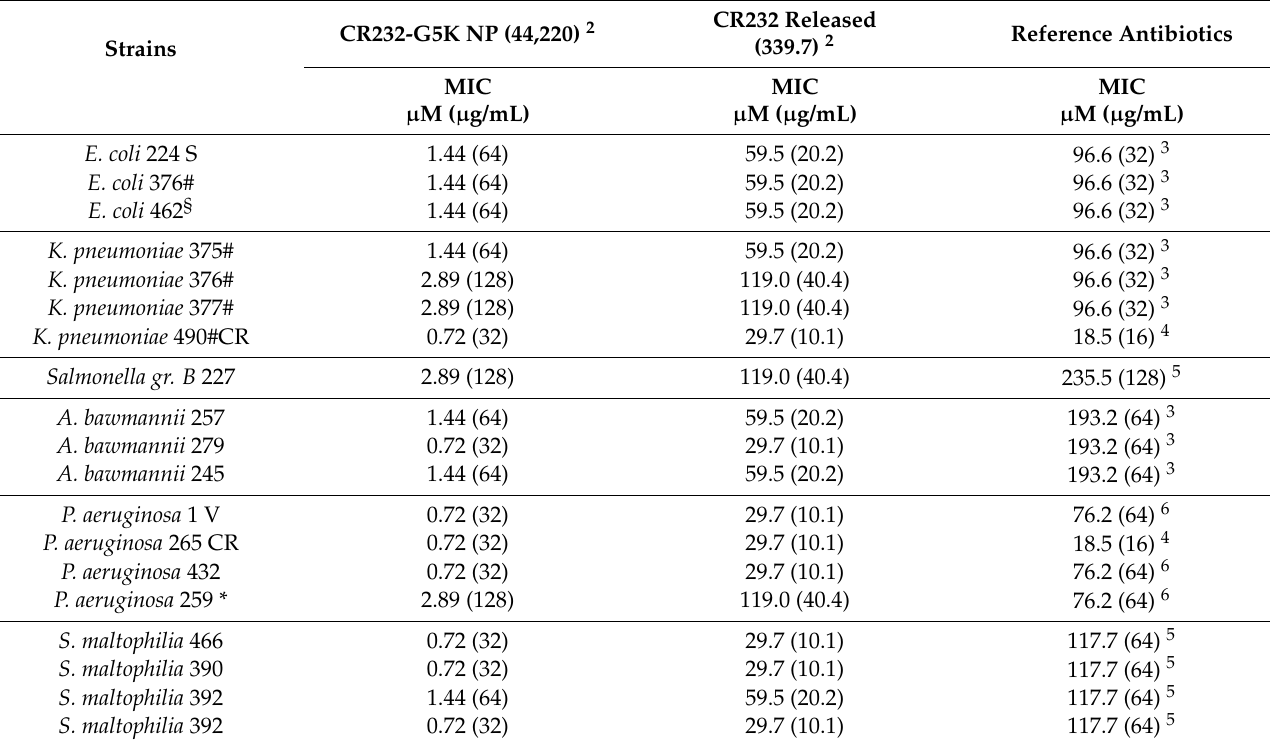
Table 5. MIC values of CR232-G5K NPs and those estimated for the CR232 (free compound) deliv- ered by the dendrimer formulation against bacteria of Gram-negative species (the isolated against which CR232-G5K NPs were inactive have been omitted), obtained from experiments carried out in triplicate 1 , and those of reference antibiotics expressed as µ M and µ